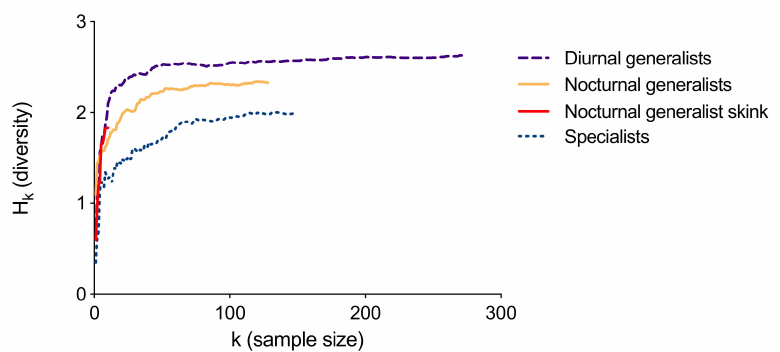
Figure 1. Cumulative diversity (H k ) of prey taxa in the diet of nocturnal generalists, nocturnal generalist skinks, diurnal generalists, and specialists with increasing sample size